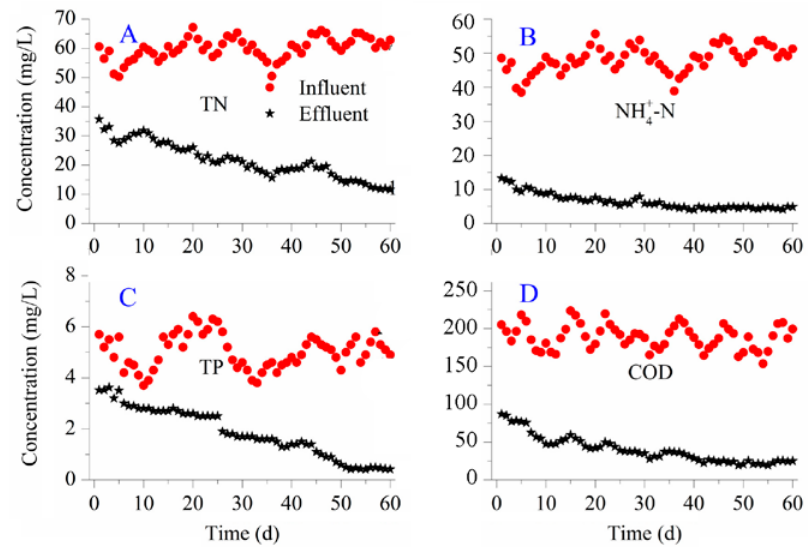
Fig. 3. Variations of COD, NH4-N, TN and TP in the influent and effluent and